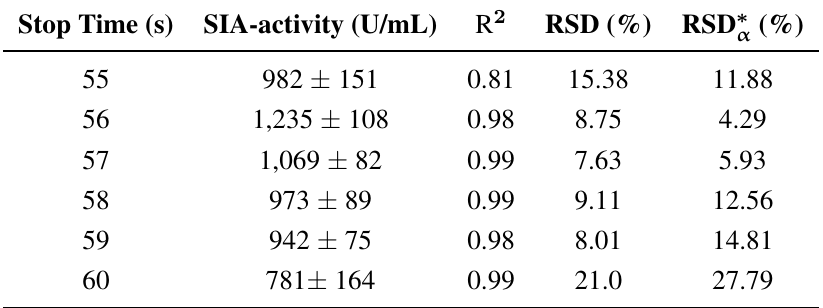
Table 2. Results from the kinetics experiments for the off-line microplate spectrophotometric method and the SIA